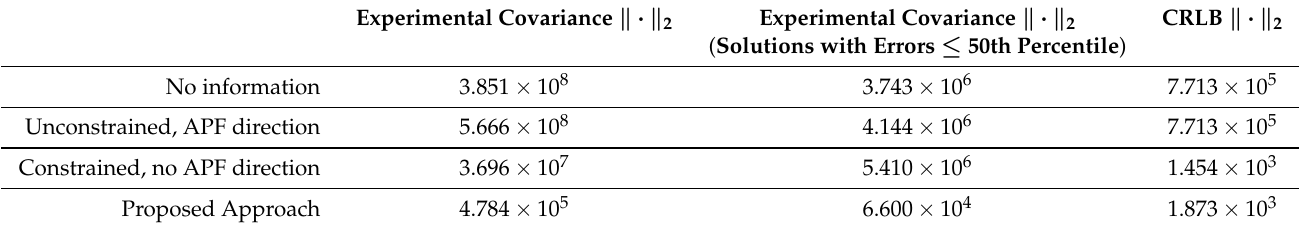
Table 3. Euclidean norm of the parameter estimation via MIDACO-SOLVER for the different operational scenarios. Experimental Covariance (cid:107) · (cid:107) 2 Experimental Covariance (cid:107) · (cid:107) 2 CRLB (cid:107) · (cid:107) 2